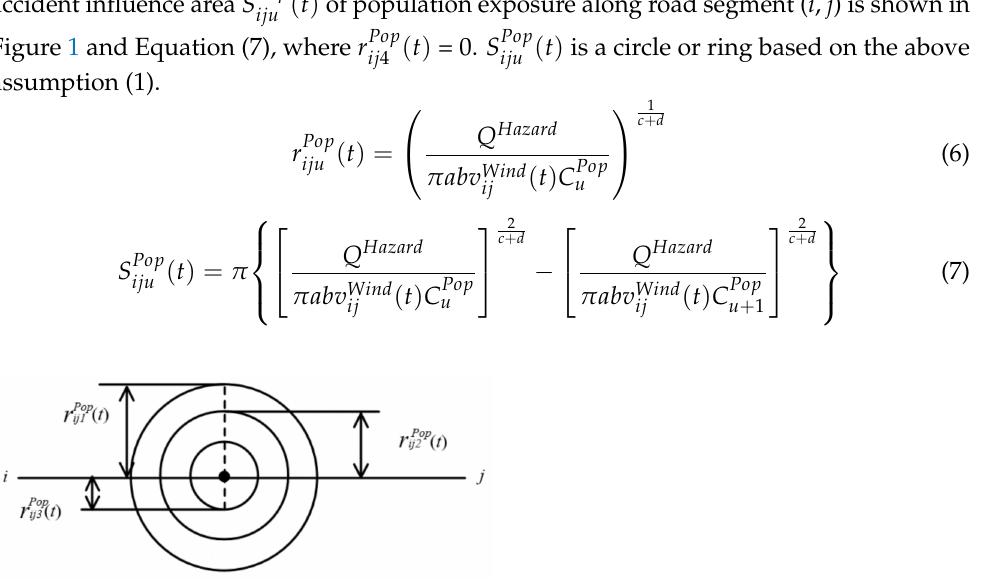
Figure 1. Accident influence area of population exposure.